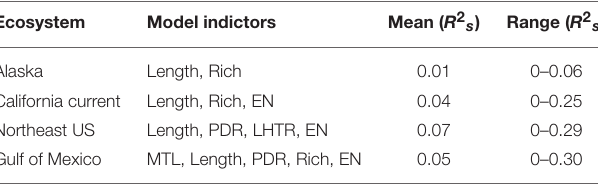
TABLE 3 | Mean Model Performance ( R 2 s ) of the out-of-bag samples for the ecological indicators in each region from the gradient forest